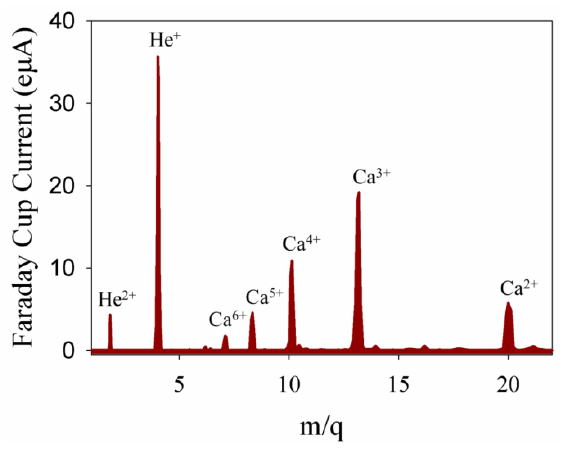
Figure 1. Calcium ion beam spectra. The extraction voltage and the temperature of the oven were 5 kV and 700 °C, respectively. The plasma was optimized for Ca 3+ .